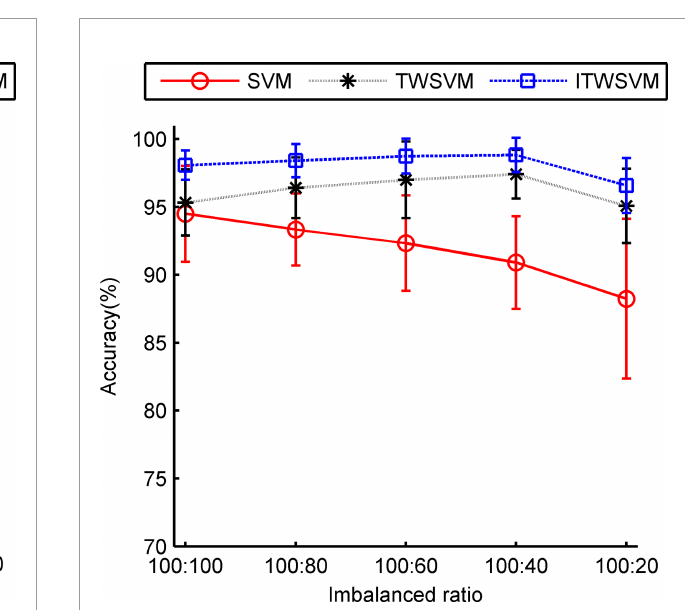
FIGURE 7 | Average and standard deviation of F-measure.